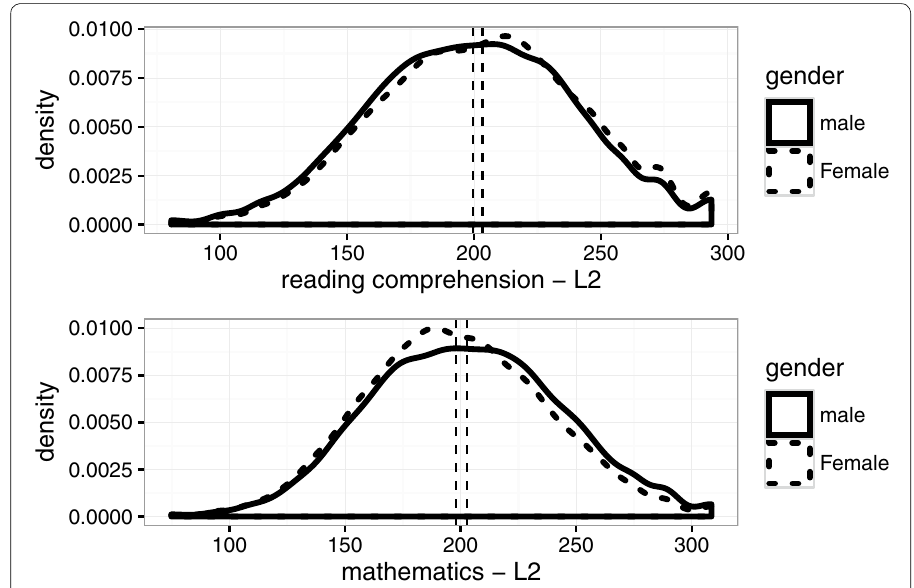
Fig. 3 Reading comprehension and mathematics achievement for second-graders by gender. The vertical dotted lines represent the group